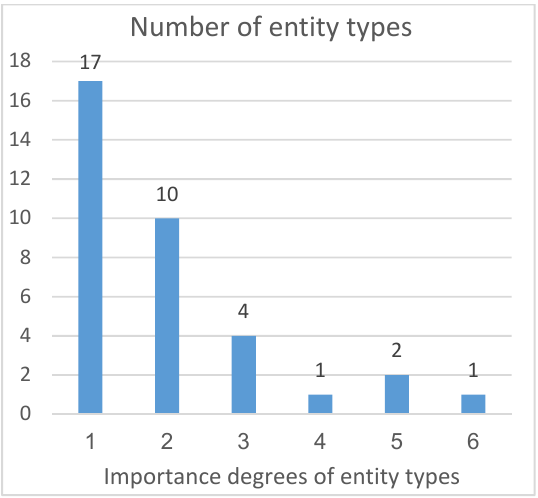
Figure 7. Number of entity types in different importance degrees.